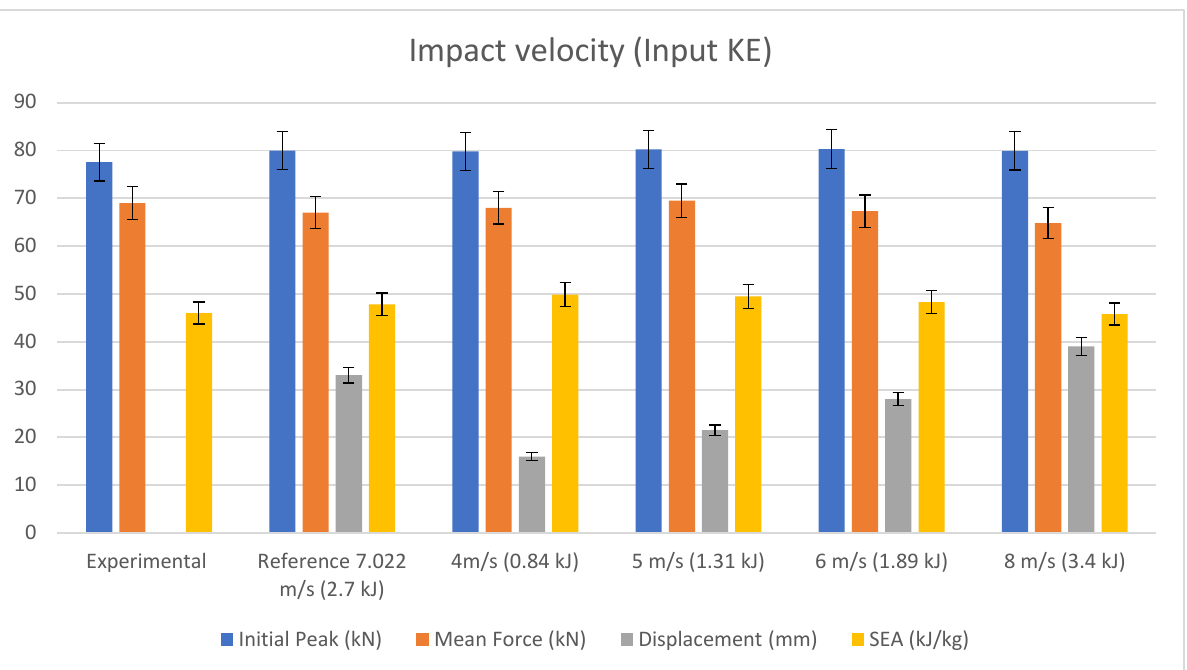
Figure 22. Impact velocity or kinetic energy input sensitivity data [66].